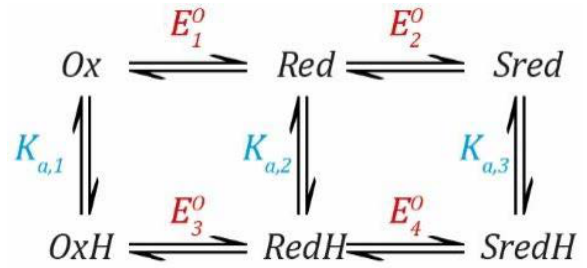
Scheme 3. Scheme showing the reactions in a simple model for the [FeFe] hydrogenase. The oxidised and deprotonated species Ox can be reduced to Red with a redox potential of E O . Red can then be 1 further reduced to Sred with a redox potential of E O . The oxidised protonated species OxH can be 2 reduced to give RedH with a redox potential of E O and RedH can be further reduced to give SredH 3 with a redox potential of E O . OxH, RedH , and SredH can be deprotonated to Ox , Red , and Sred , 4 respectively, with acid dissociation constants K a, 1 , K a, 2 , and K a, 3 ,